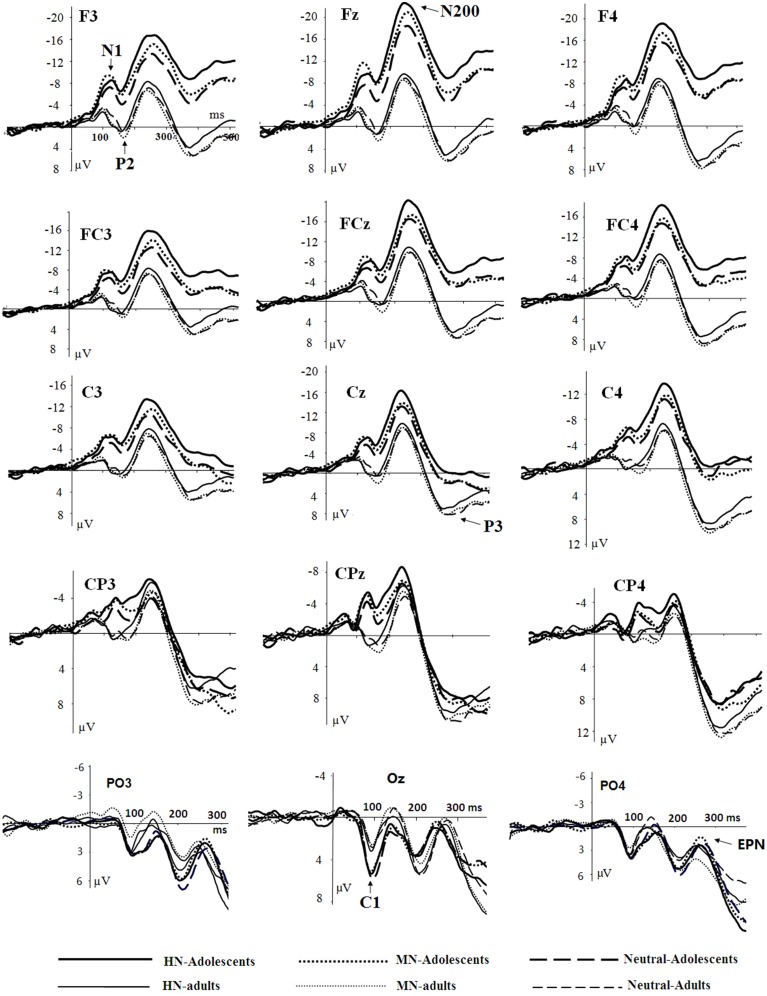
Averaged ERPs elicited by HN (solid lines), MN (dotted lines), Neutral (dashed lines) stimuli in adolescents (bold lines) and adults (thin lines) at F3, Fz, F4 (frontal); FC3, FCz, FC4 (frontocentral); C3, Cz, C4 (central); CP3, CPz, CP4 (centroparietal), and PO3, Oz, PO4 (parietal-occipital) sites.